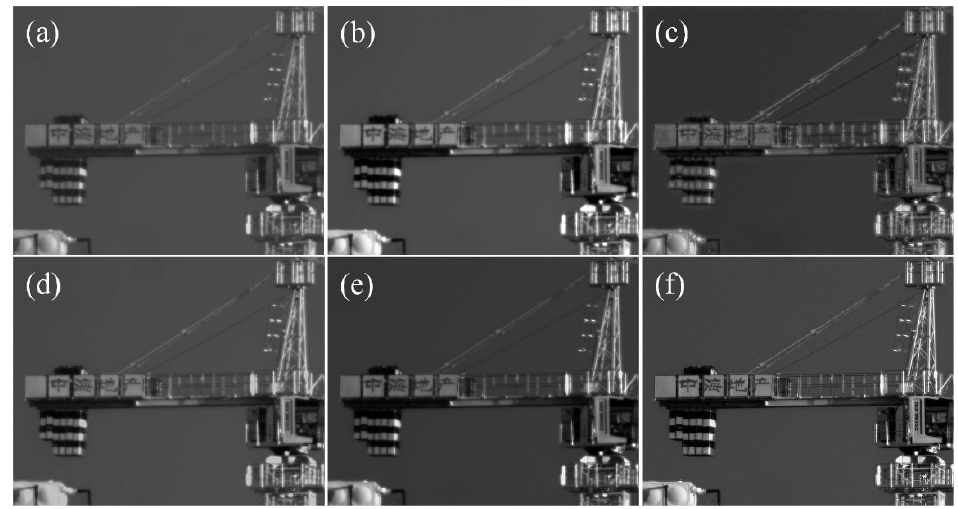
Figure 11. Enhancement results of Image 2: ( a ) input image; ( b ) PE; ( c ) BF&DDE; ( d ) GF&DDE; ( e ) FGF&PE; ( f ) proposed method.